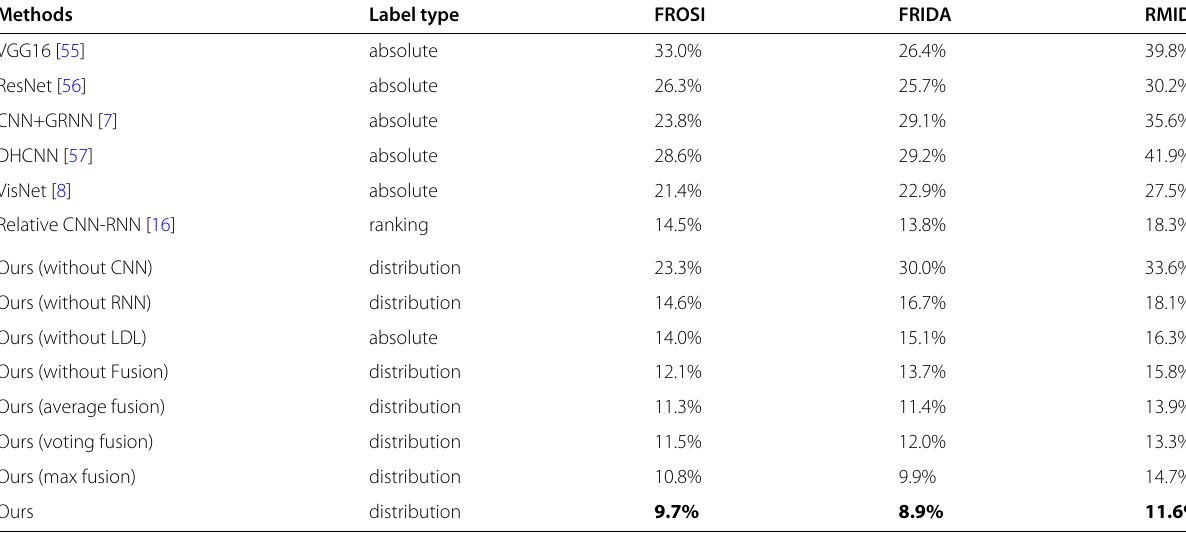
Table 4 Comparisons with state-of-the-arts and ablation study